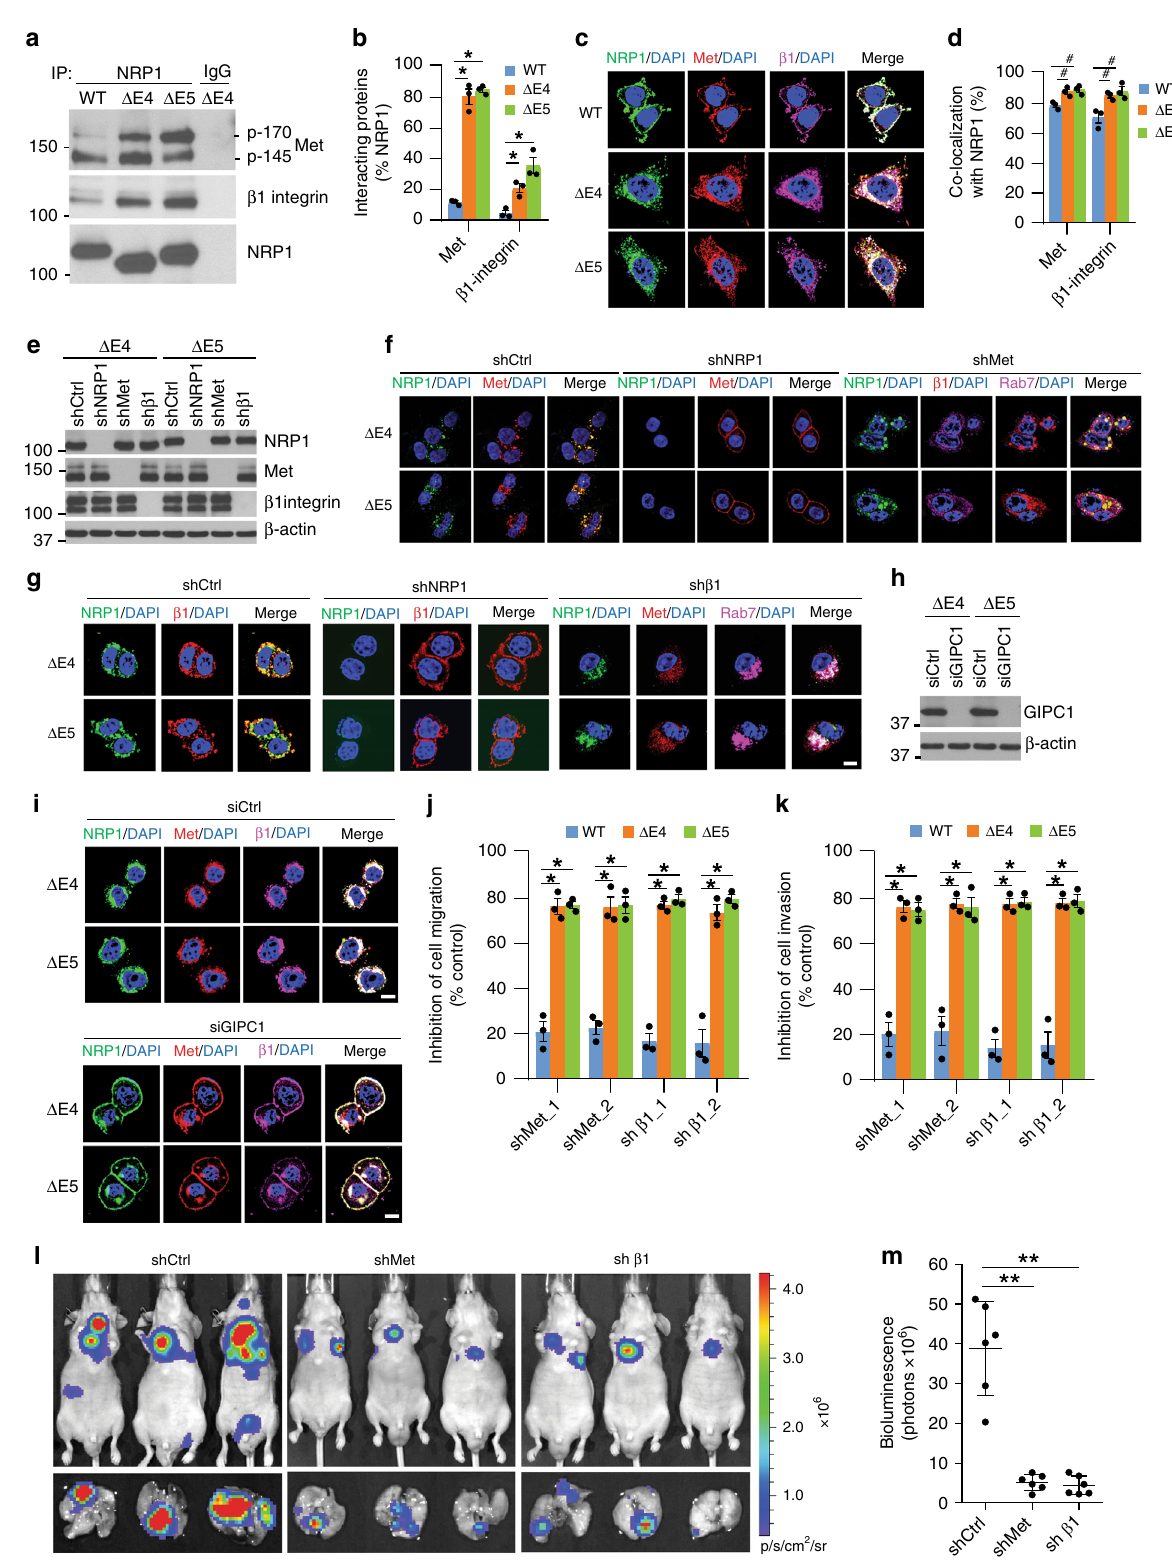
interaction with both the precursor (p-170) and mature β -chain NRP1 variants in intracellular compartments (Fig. 6c, d; Sup- (p-145) forms of Met, as well as with β 1-integrin (Fig. 6a, b). plementary Fig. 6a, b). By contrast, Met co-localized with Remarkably, immuno fl uorescence staining and separation NRP1-WT on the plasma membrane (Fig. 6c, d). Interestingly, procedures using a cell surface biotinylation assay revealed that active β 1-integrin (12G10 antibody) 34 was also visible pre- dominantly in punctate cytoplasmic structures and largely Met was highly internalized and co-localized with the two NATURE COMMUNICATIONS| (2019) 10:3708